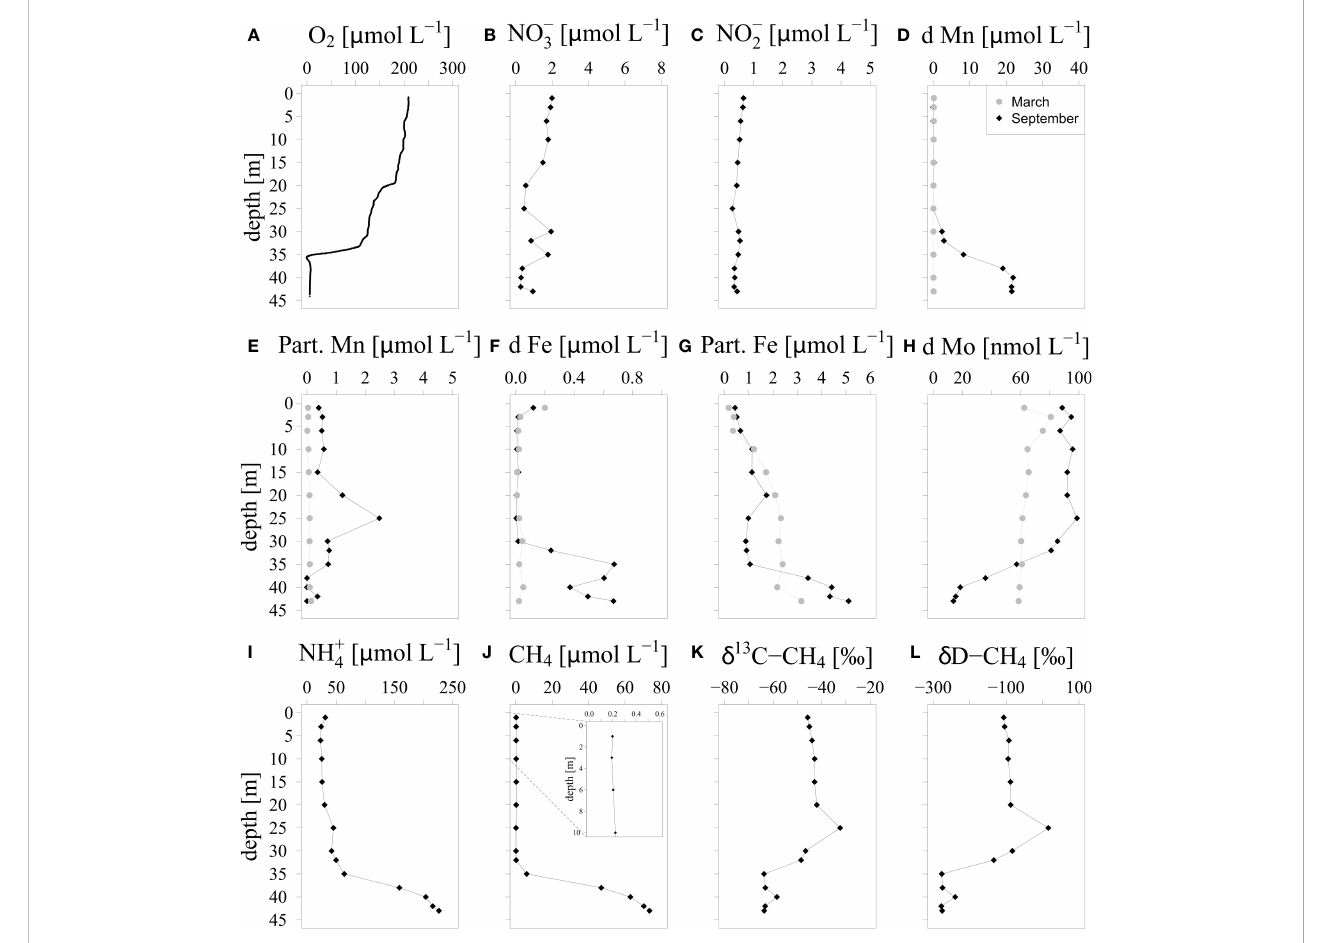
FIGURE 4 Water column depth pro fi les of (A) : O 2 , (B) : nitrate, (C) : nitrite, (D) : dissolved and (E) : particulate Mn (d Mn, Part. Mn), (F) : dissolved and (G) : particulate Fe (d Fe, Part. Fe), (H) : dissolved Mo (d Mo), (I) : NH + 4 , (J) : CH 4 , (K) : d 13 C-CH 4 and (L) : d D-CH 4 . d 13 C-CH 4 values are given in ‰ vs. VPDB (Vienna Pee Dee Belemnite) and d D-CH 4 values are given in ‰ vs. V-SMOW (Vienna Standard Mean Ocean